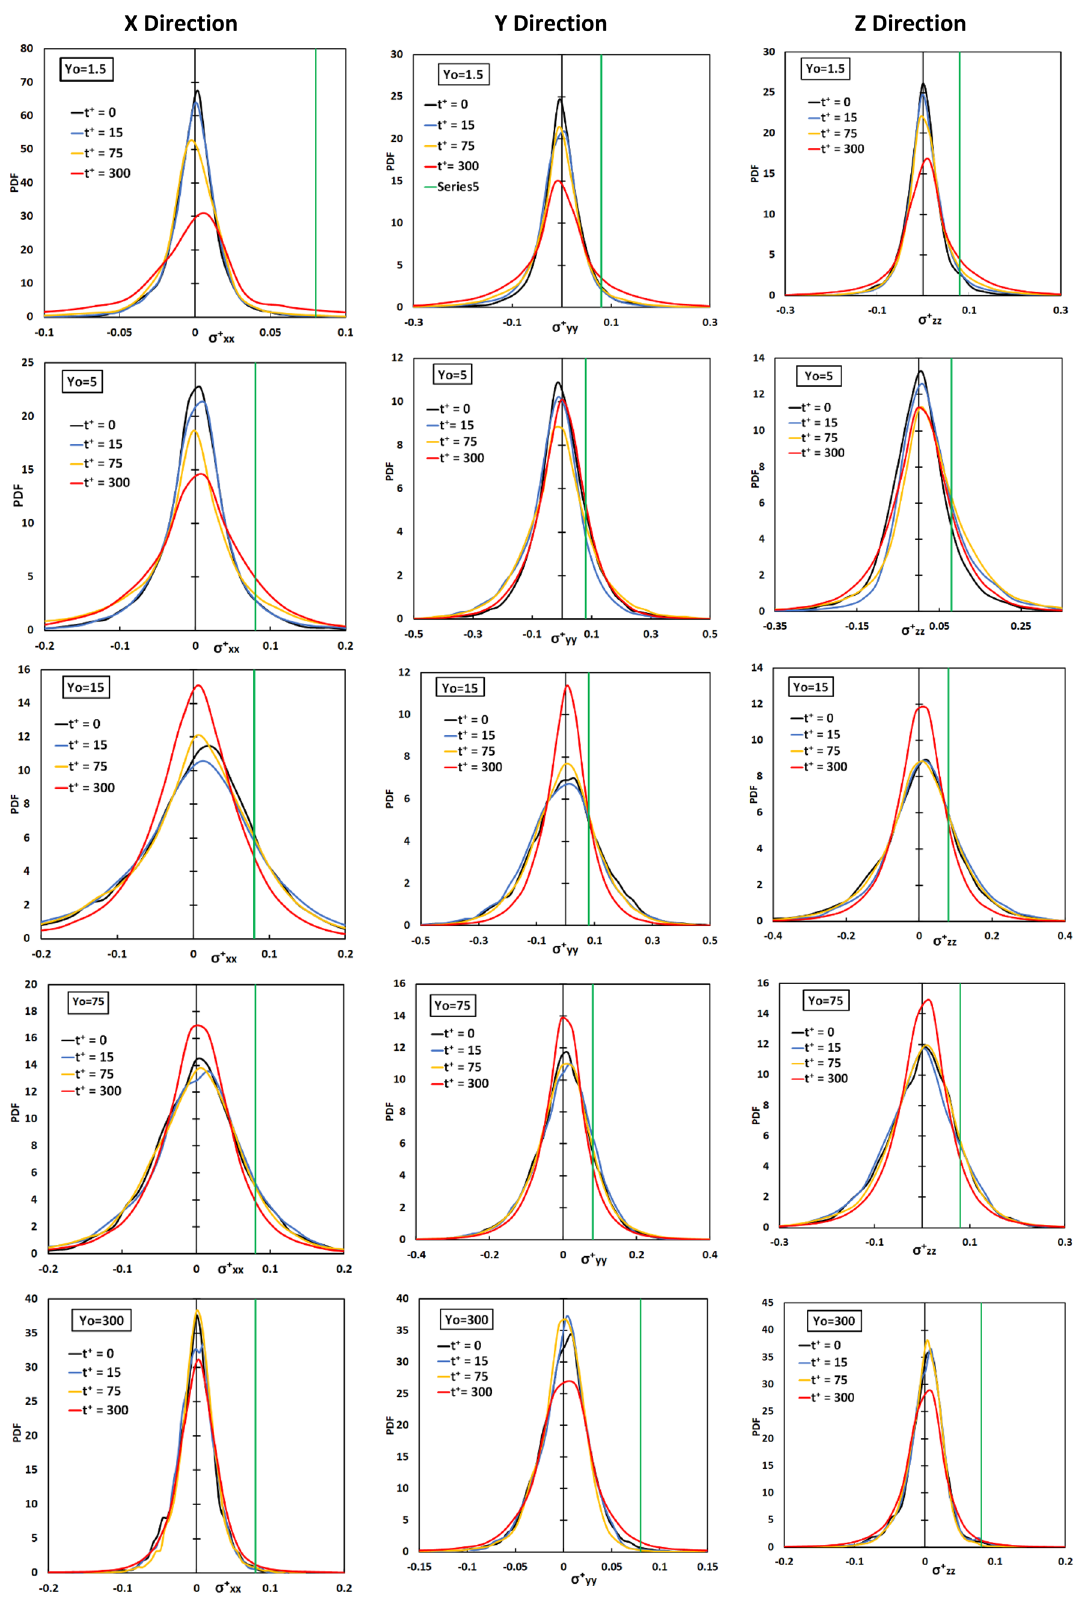
Figure 7. Probability density function for the extensional stress components in x, y, z directions of particles released at Yo = 1.5, 5, 15, 75, 300 at different time instances in the Poiseuille flow field. The solid green line depicts the critical stress value for vWF